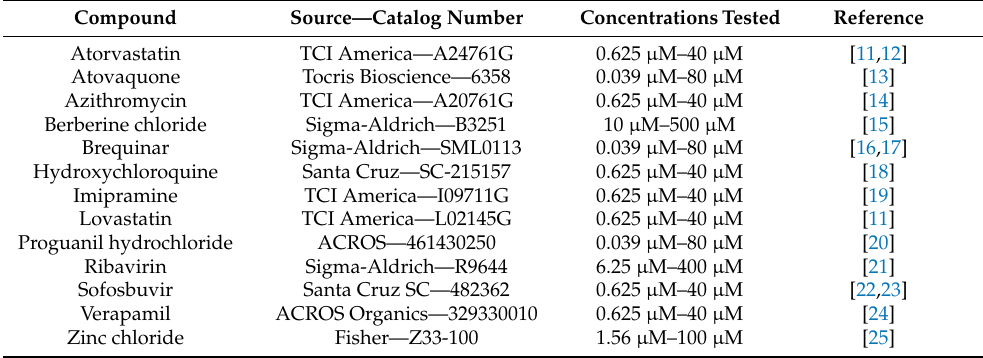
Table 1. Compounds used in this